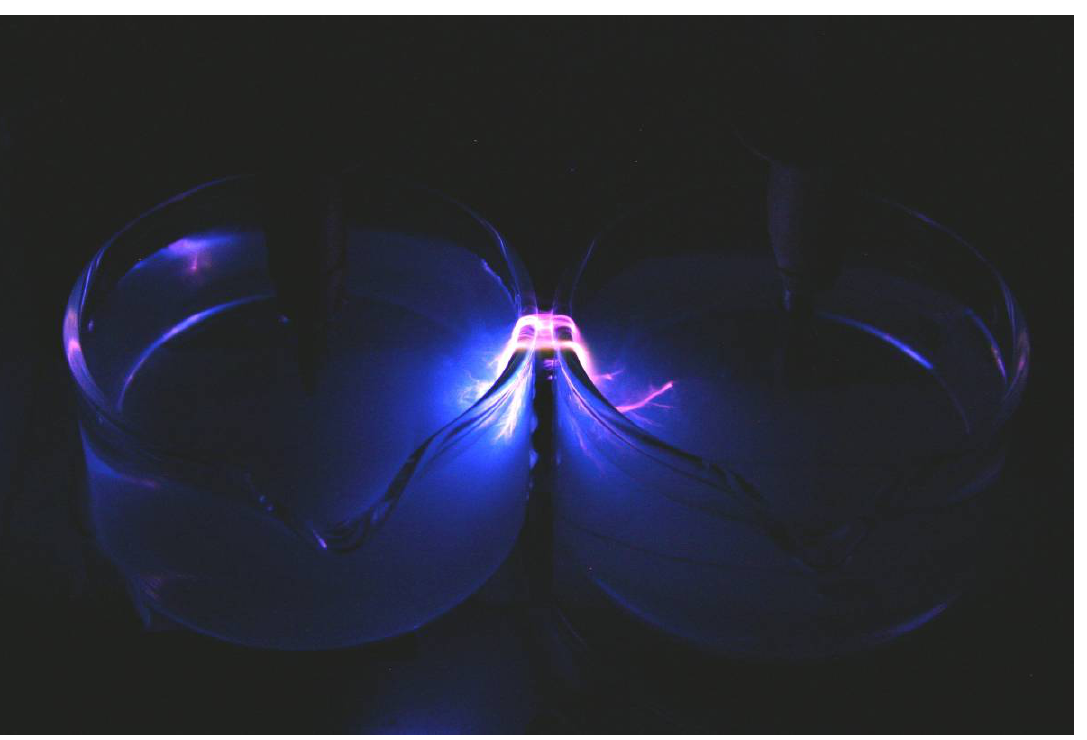
Figure 14. Discharge before the water bridge formation with diluted luminol solution. 12–14 kV dc, 0.5 mA